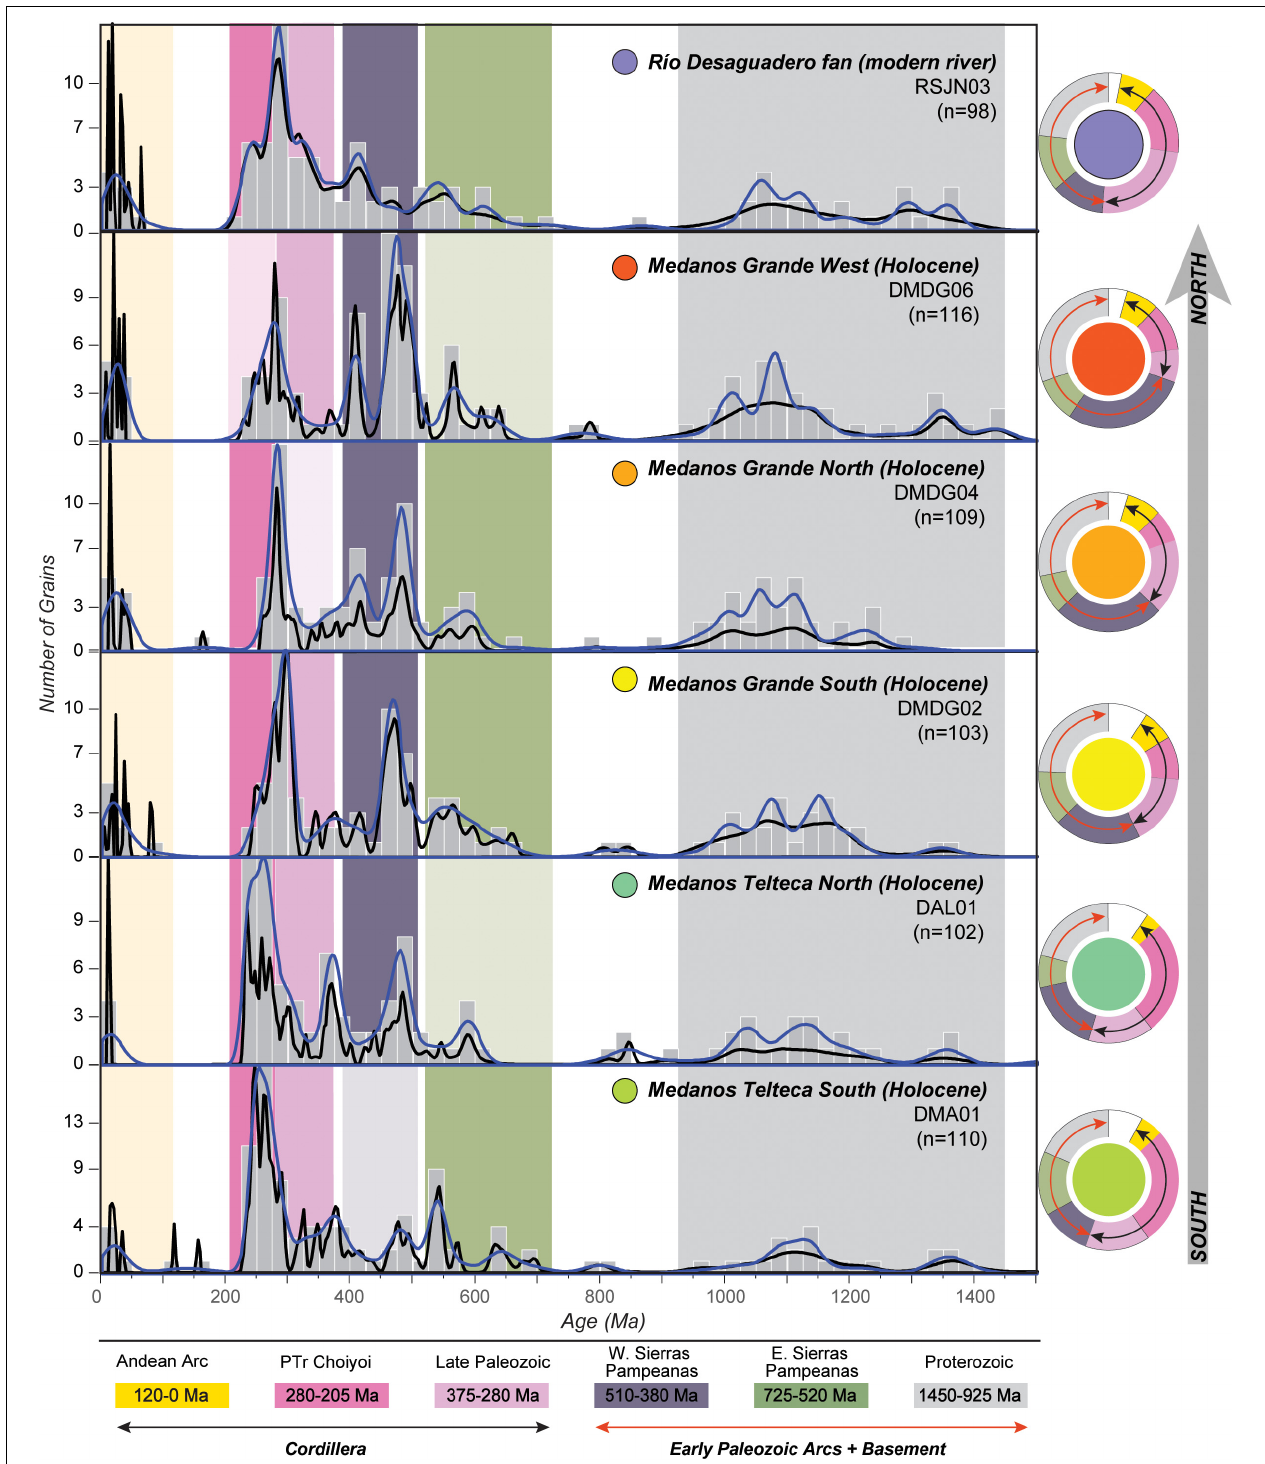
FIGURE 4 | Comparative plot of DZ U-Pb age distributions for Holocene eolian samples and modern river sand, depicted as age histograms (gray rectangles), kernel density estimates (blue line) and relative probability density plots (black line), with emphasis on key age populations (dark color shading) and minor to no age populations (transparent color shading). Donut diagrams represent percent abundance of key age populations in each sample, with Cordillera (black arrows) and Early Paleozoic Arcs and Basement (red arrow) age groups emphasized, and inner colored circle corresponds to sample locations in Figure 2B .